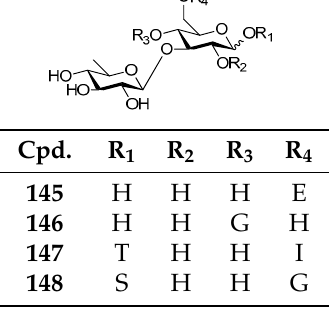
Figure 12. Structures of compounds 145 – 147 .